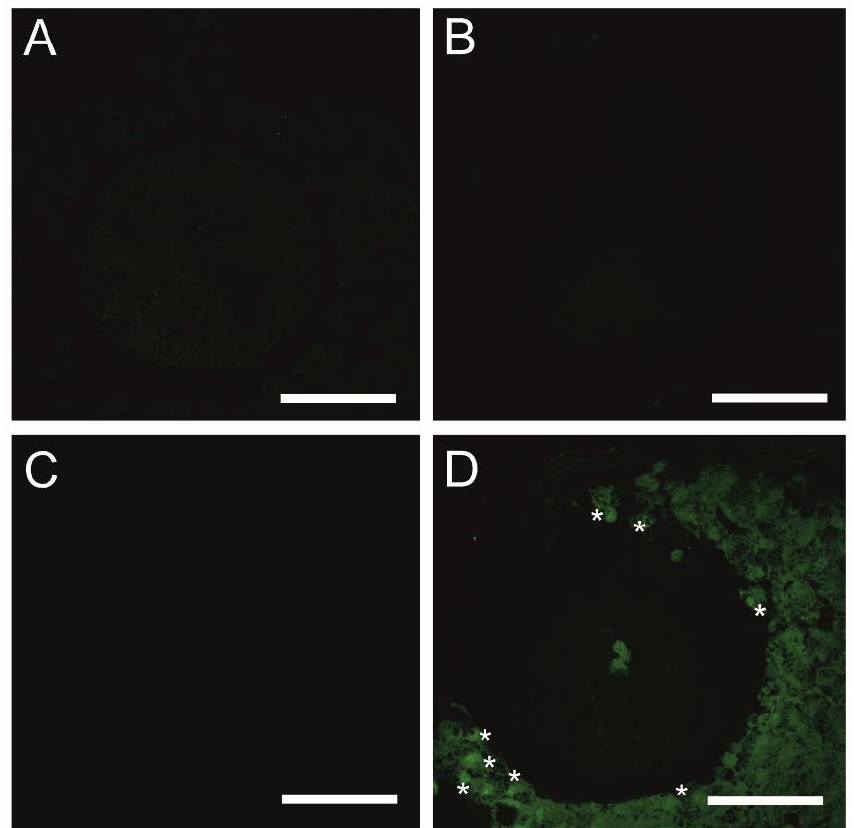
Figure 5. Detection of mitophagy in porcine COCs subjected to the IVM procedure using a 3D culture model (alginate capsules) in control cultures ( A ) or in experimental cultures: in the presence of vinclozolin ( B ), nandrolone ( C ) or cyclosporin A ( D ). White asterisks indicate colocalization of lysosome and mitochondrion. Scale bars represent 50 µm (magnification 40×).